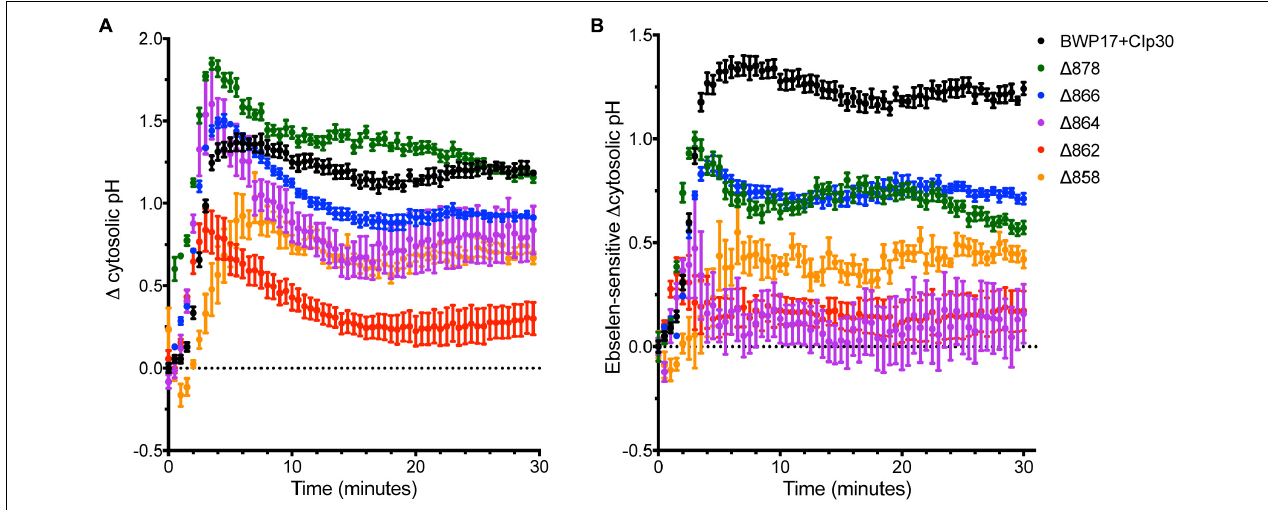
FIGURE 4 | Cytosolic pH alkalinization in response to glucose addition is altered in Pma1p truncation mutants. After a 30 min period of glucose starvation, glucose was added to wild-type and Pma1p truncation mutant cells and cytosolic pH was measured at 30 s intervals. The addition of glucose to glucose-starved cells causes a rapid and dramatic increase in cytosolic pH of nearly 1.5 units in wild-type cells. Increasing Pma1p truncation decreases this glucose-induced pH change. Graphs represent a single representative experiment; experiments were conducted at least four times. (A) Change in pH upon glucose addition ( (cid:49) pH i ) was calculated by subtracting cytosolic pH immediately prior to glucose addition from cytosolic pH at each timepoint after glucose addition. The (cid:49) 862 and (cid:49) 858 strains exhibit lower cytosolic pH response to glucose than the wild-type control strain. (B) Ebselen-sensitive (cid:49) pH i , or Pma1p-specific glucose response, was calculated by subtracting (cid:49) pH i in wells treated with 50 µ M of the H + -ATPase inhibitor ebselen from (cid:49) pH i in non-ebselen treated wells at each timepoint. Ebselen-sensitive (cid:49) pH i is significantly lower than (cid:49) pH i , potentially indicating the presence of compensatory cytosolic alkalinization mechanisms in Pma1p truncation mutants.